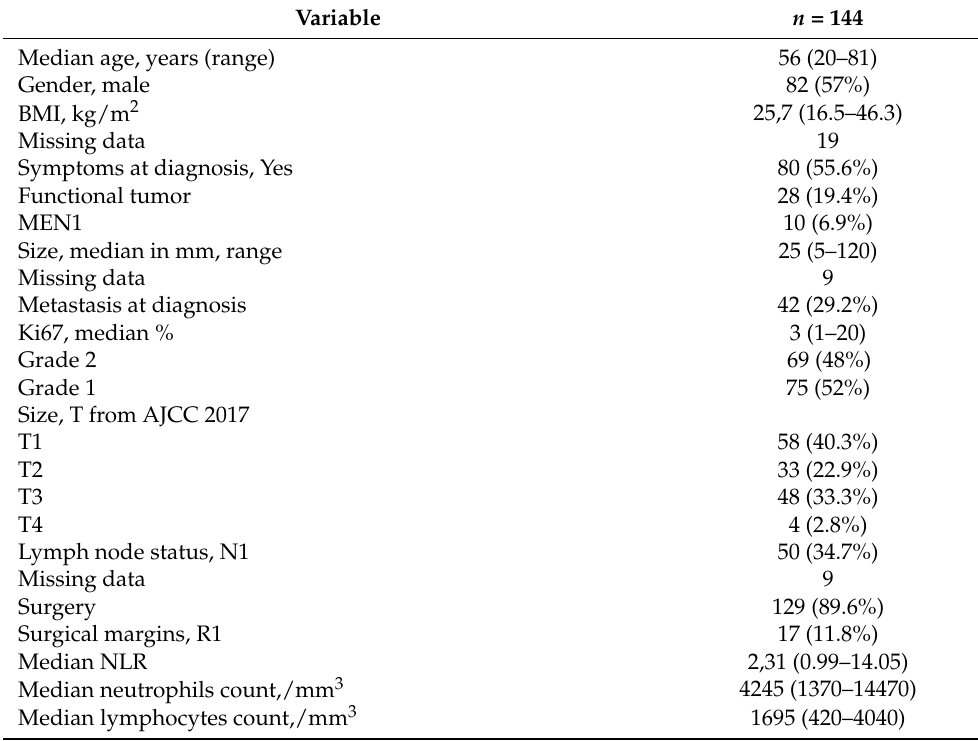
Table 1. Baseline clinicopathological characterization of the current